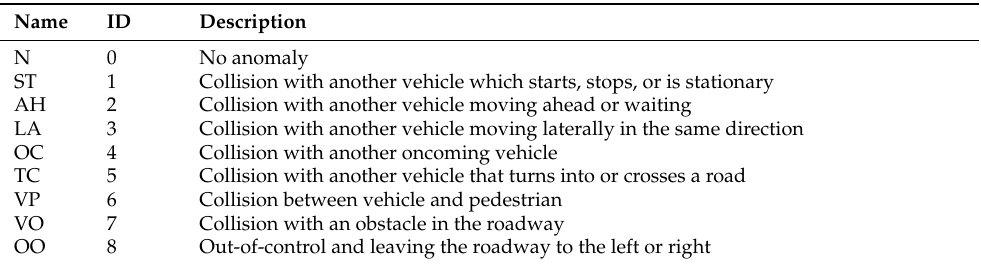
Table 3. Event Classes in the DoTA dataset